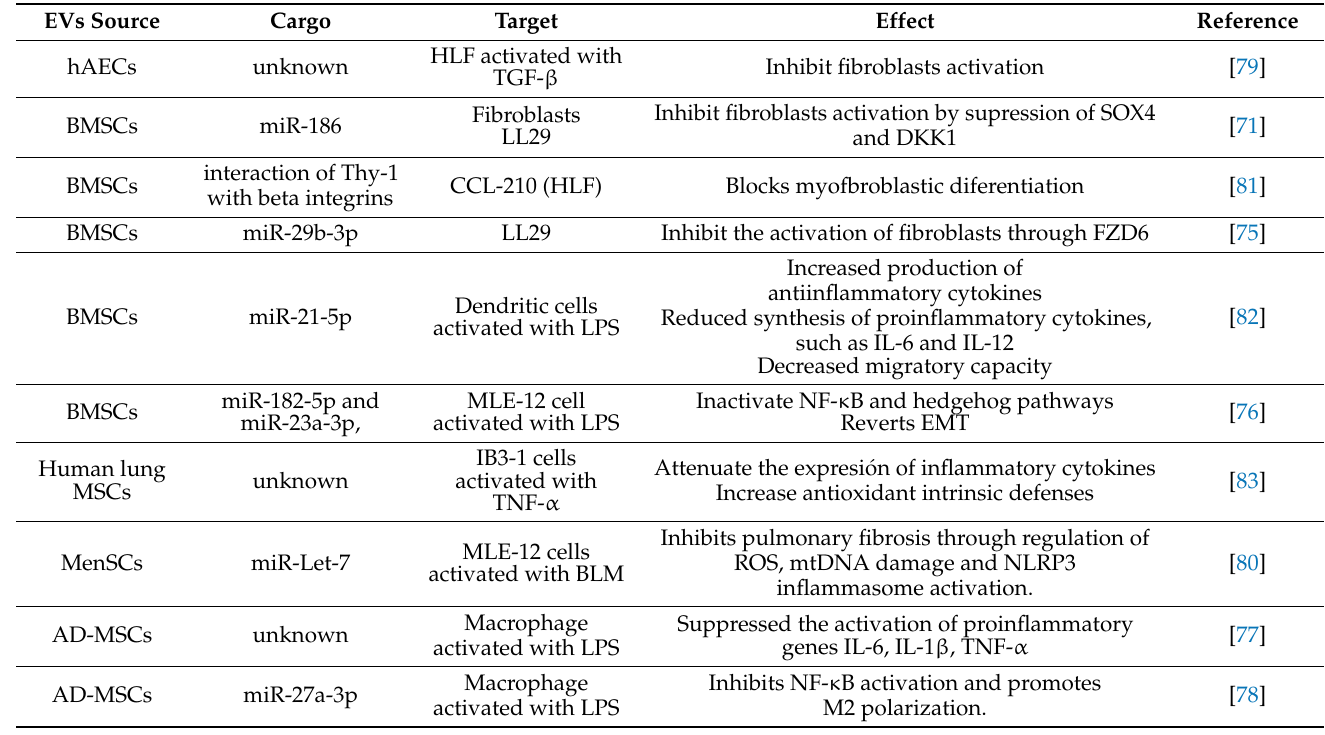
Table 2. Summary of studies in vitro models of IPF and other lung diseases with therapeutic